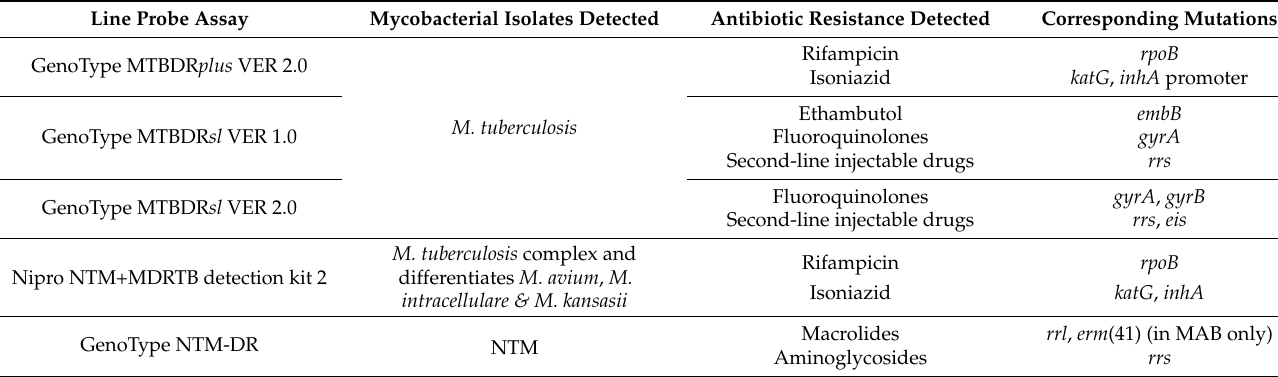
Table 2. Line probe assays for detecting resistance in mycobacterial isolates